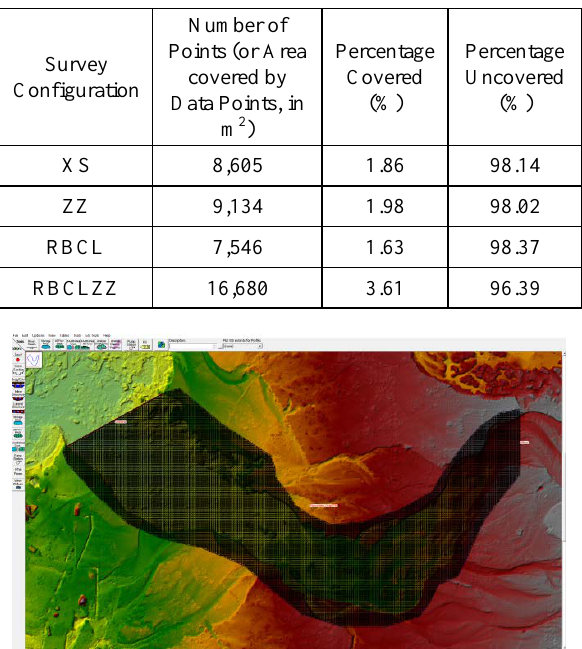
Figure 2. The HEC RAS 2D computational domain, with the LIDAR DTM in the background.